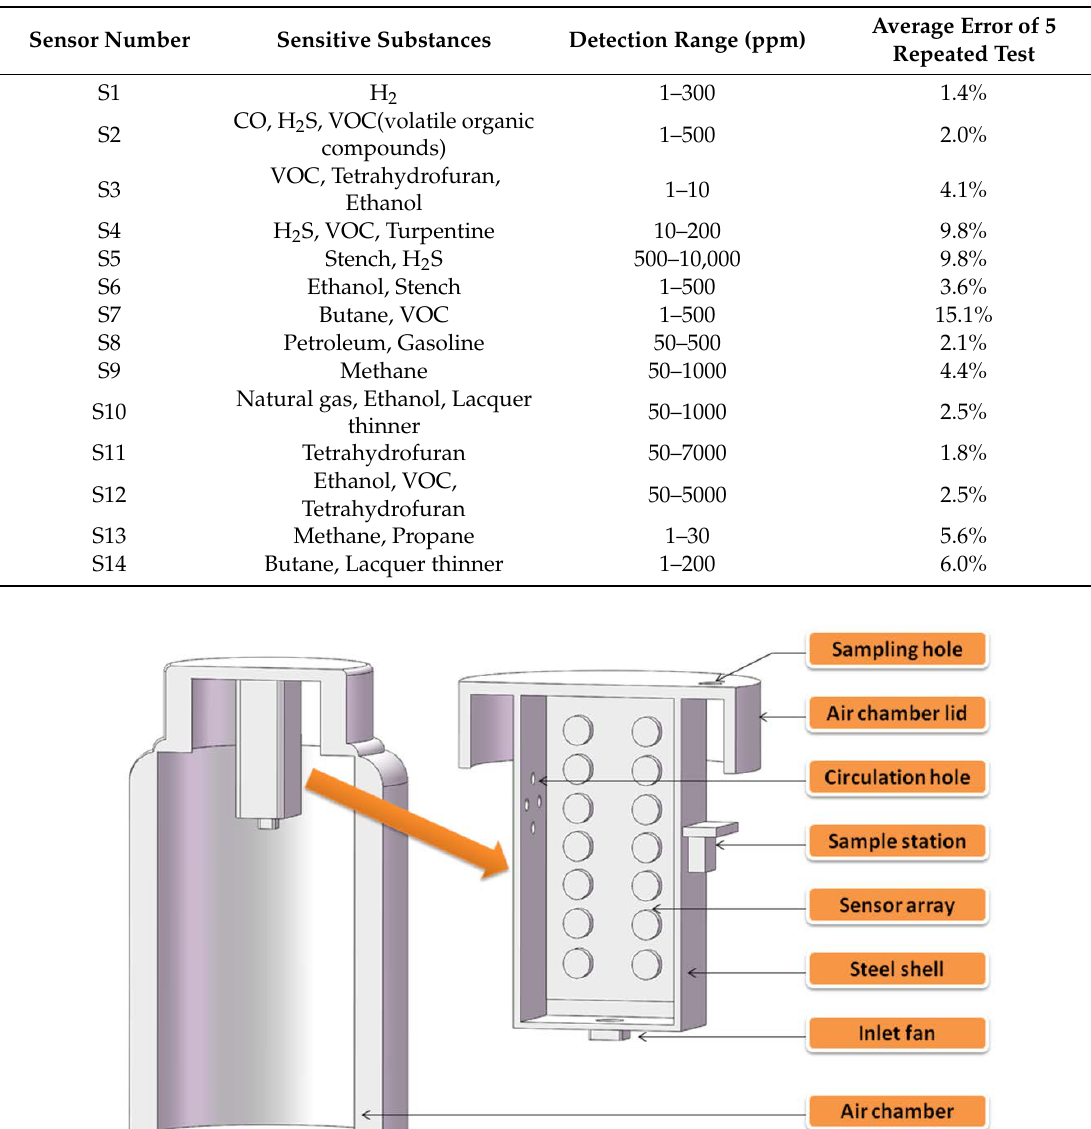
Table 1. Properties of metal oxide sensors in the array.